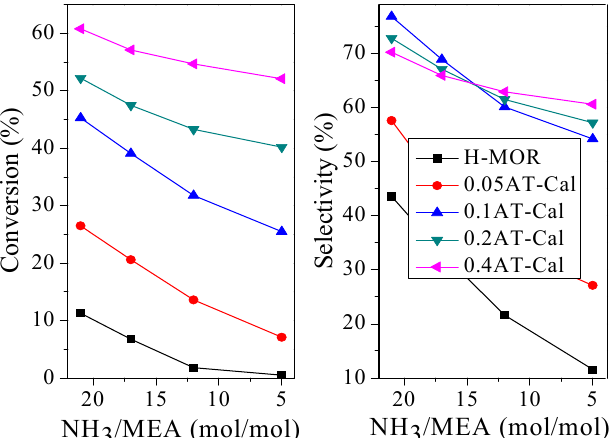
Figure 8. E ff ect of NH 3 / MEA molar ratio on the catalytic performance. Reaction conditions: temperature Figure 8. Effect of NH 3 /MEA molar ratio on the catalytic performance. Reaction conditions: = 310 ◦ C, pressure = 4.0 MPa, LHSV = 4.58 h − 1 temperature = 310 °C, pressure = 4.0 MPa, LHSV = 4.58 h − 1 .